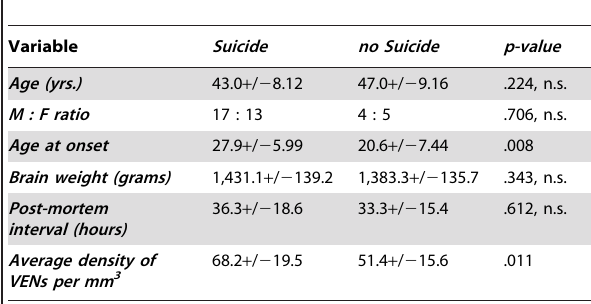
Table 1. Comparison of demographic and brain related variables between subjects with psychosis who committed suicide and subjects who died from non-suicidal